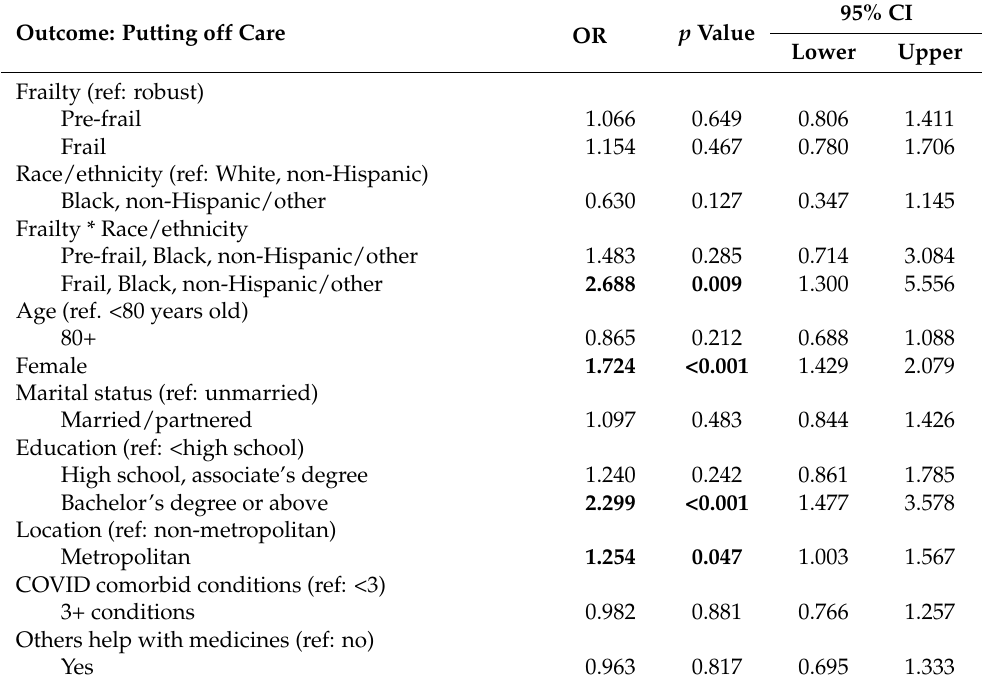
Table 3. Logistic regression results for putting off